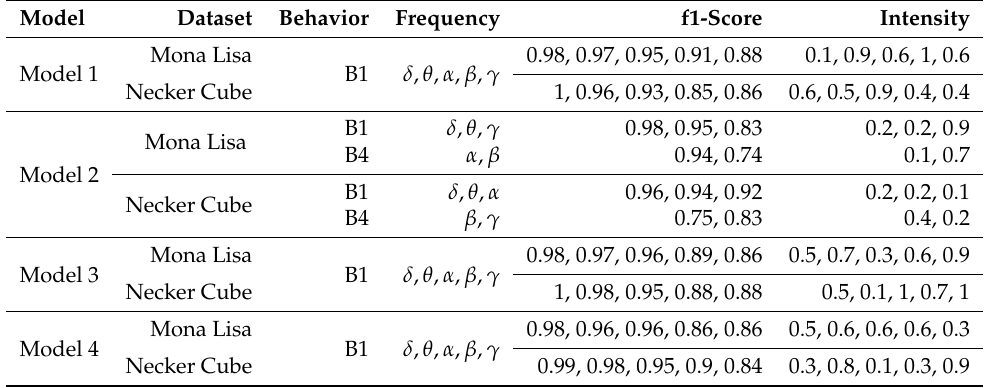
Table 10. The results of using the models with AdaMax optimizer for intensity classification.